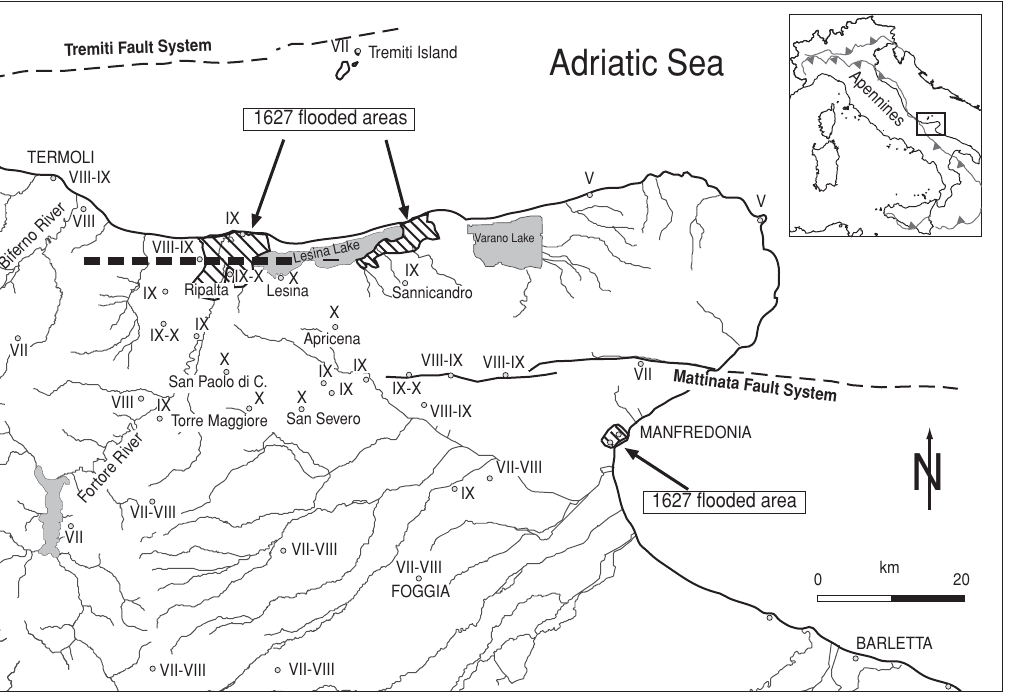
Fig. 1. Damage distribution of the June 30, 1627 earthquake. Intensities are plotted in roman numbers (Boschi et al. , 2000). Areas inundated by the 1627 tsunami are also shown. The thick dashed line north of Lesina repre- sents the best candidate for the source responsible for the 1627 earthquake and tsunami as proposed by Tinti and Piatanesi (1996).